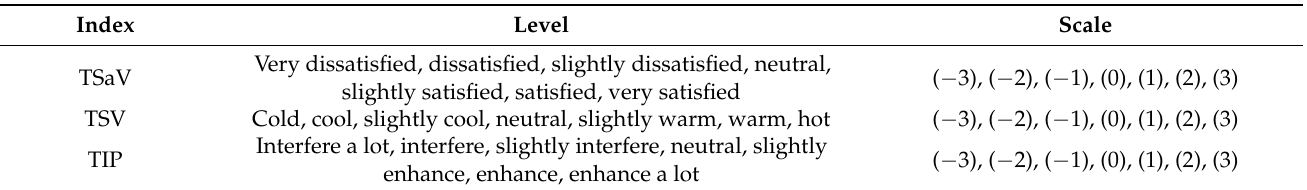
Table 3. Scales used in the questionnaire survey.